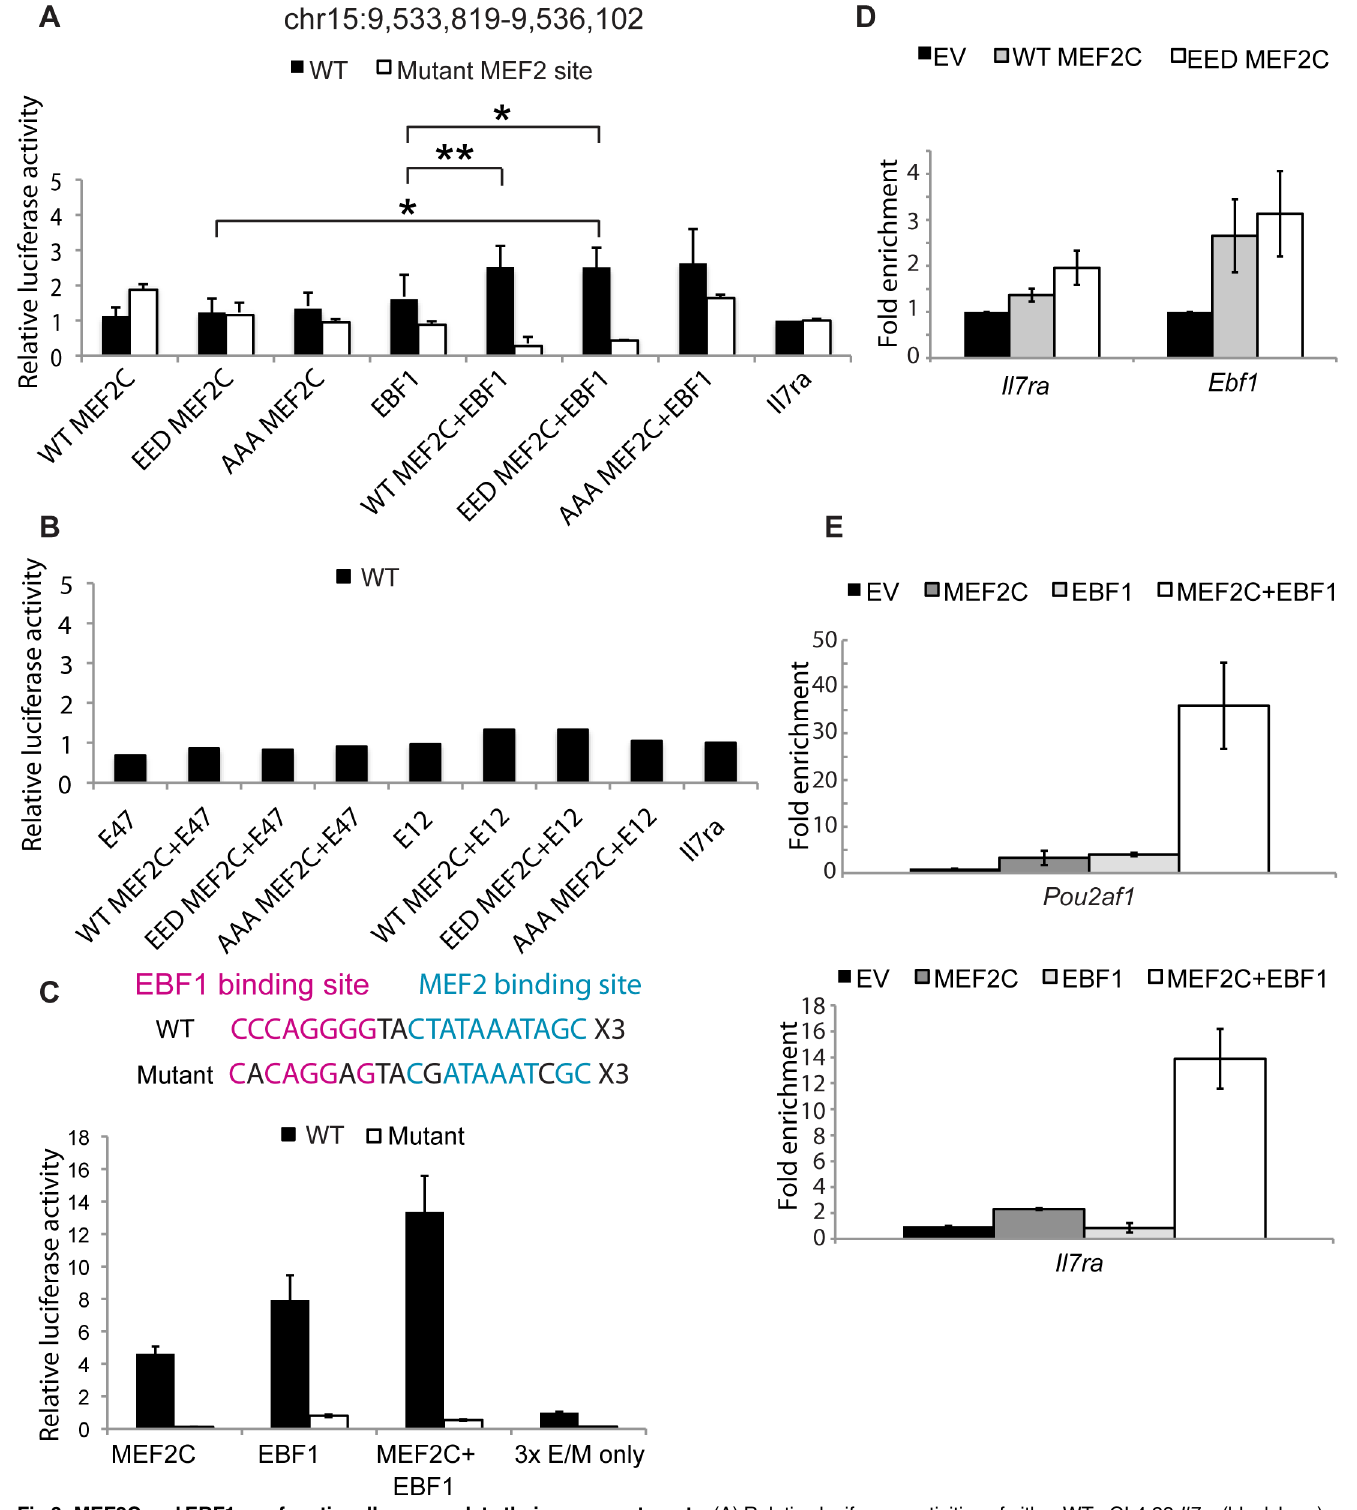
Fig 3. MEF2C and EBF1 can functionally co-regulate their common targets. (A) Relative luciferase activities of either WT pGL4.23- Il7ra (black bars) or pGL4.23- Il7ra containing mutated MEF2C binding site (white bars) in 293T cell lysates expressing FLAG-tagged WT, EED, or AAA MEF2C, and/or Myc- tagged EBF1, as indicated on the x-axis. Renilla luciferase was used as internal control, and the experiments were performed in biological triplicates,